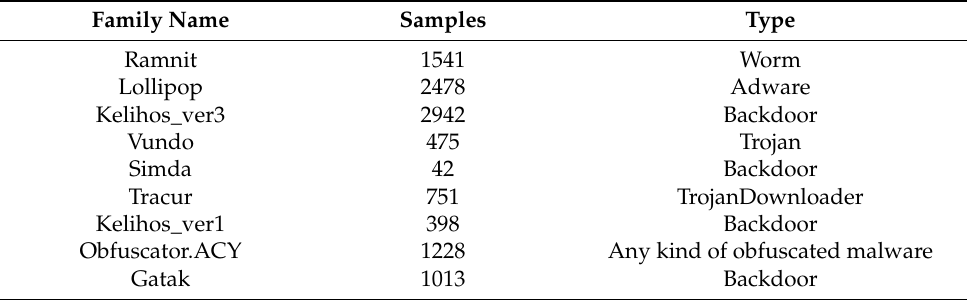
Table 1. Quantity Distribution of Sample Kaggle